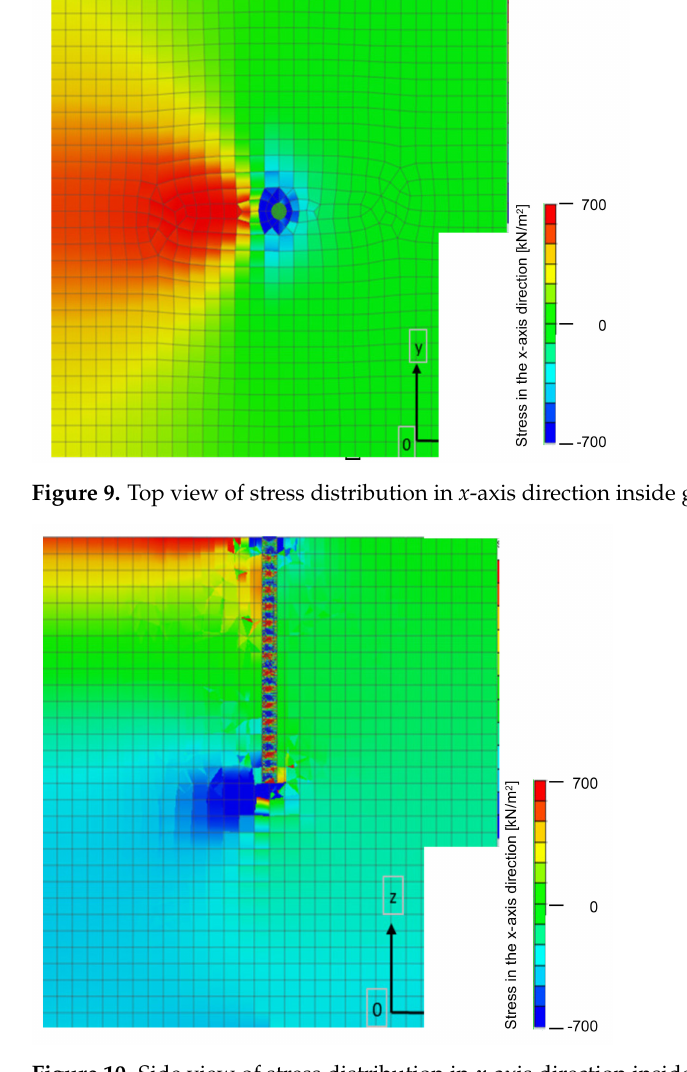
Figure 10. Side view of stress distribution in x -axis direction inside ground for